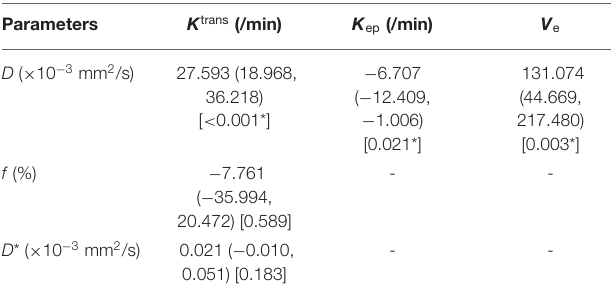
TABLE 5 | Results of multivariable regression analyses.